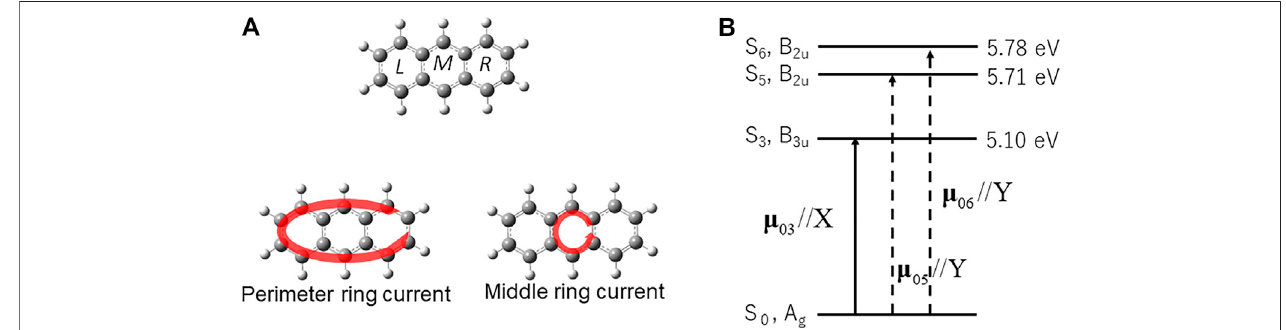
FIGURE 7 | (A) Symmetry-adapted ring currents (B 1g ) in anthracene, perimeter ring current, and middle ring current. (B) The electronic excited states adapted for laser control of π -electron ring in anthracene (D 2h ), and the non-zero transition dipole moments between the ground/excited-excited states. The solid (dashed) arrows represent the transition dipole moments which are parallel to the X (Y) axis.